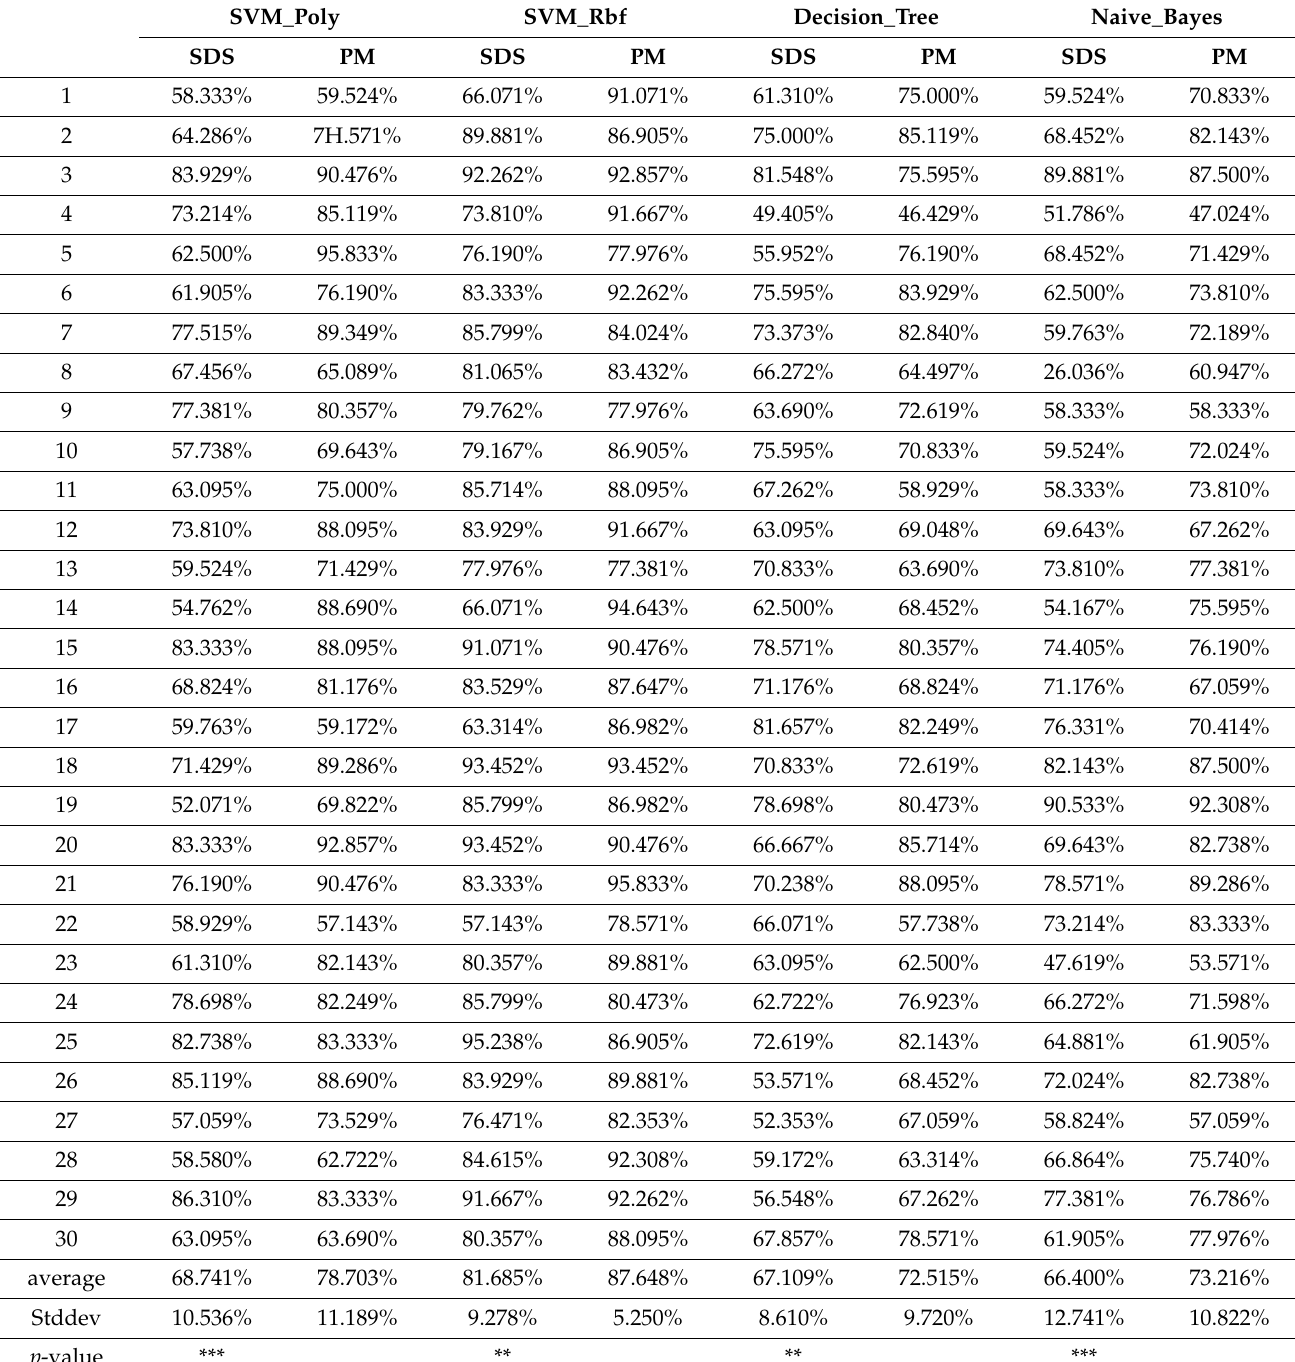
Table 2. The result of generating virtual samples by WGAN_MTD (10 TD,